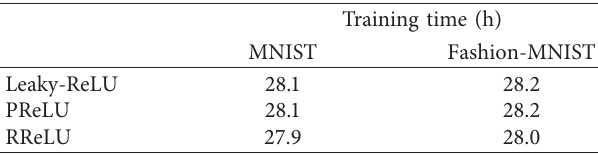
Figure 5: The height distribution images of each layer of diffraction grating and the output images of each layer of diffraction grating are obtained. (a) Label 7 in the MNIST dataset. (b) Label 9 in the Fashion-MNIST dataset. Table 1: The training time of the N-D 2 NN model using three ReLU activation functions for the MNIST dataset and Fashion-MNIST dataset.